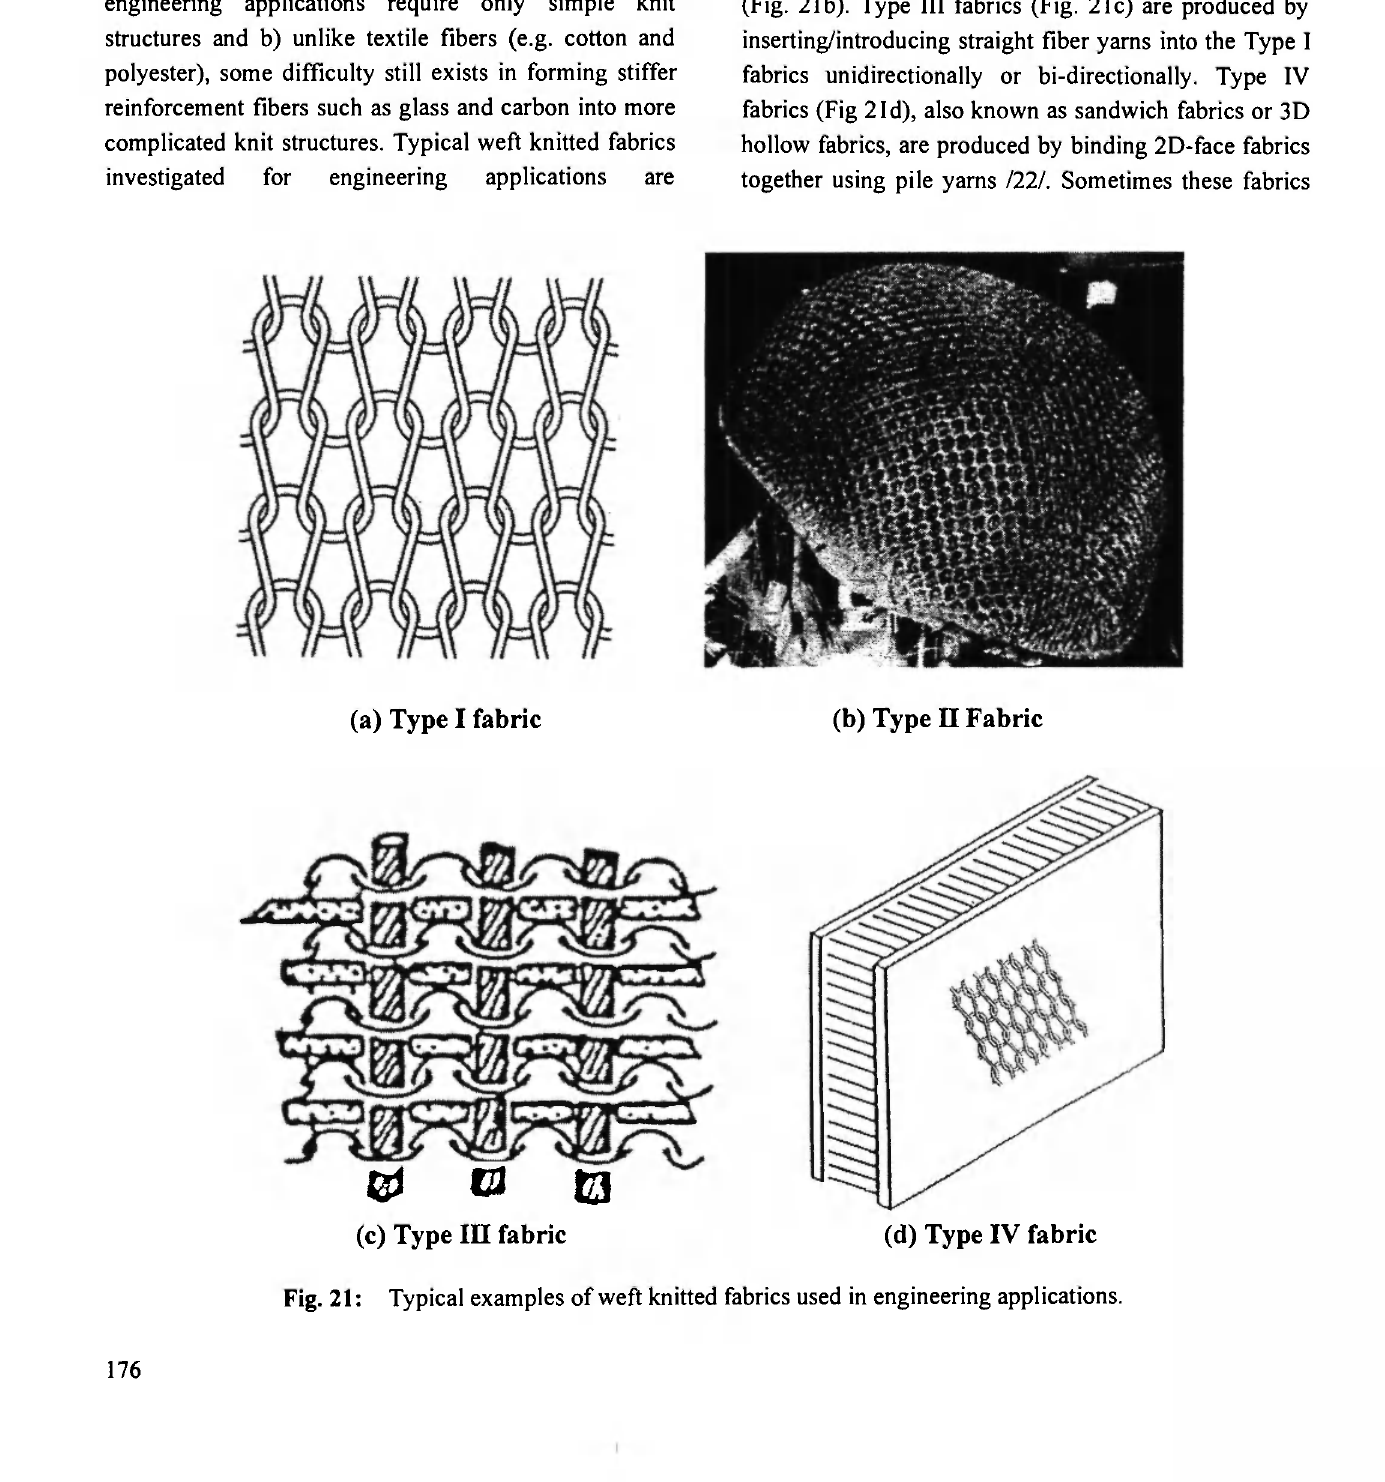
Fig. 21: Typical examples of weft knitted fabrics used in engineering